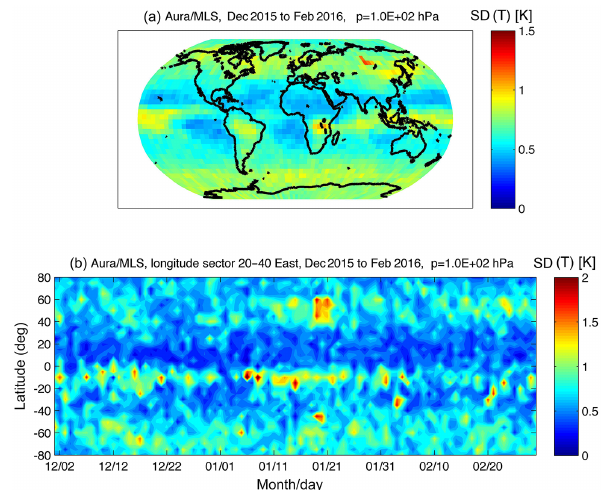
Figure 7. (a) Global map of inertia-gravity wave activity (SD( T )) at 100hPa ( z ∼ 16km) in the upper troposphere–lower stratosphere re- gion, averaged for the time interval from December 2015 to Febru- ary 2016. (b) Temporal evolution of SD( T ) in the African longitude sector (20 to 40 ◦